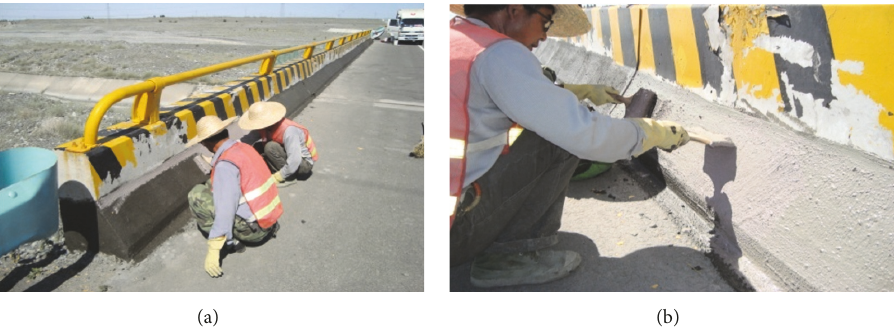
Figure 11: Paining of the acrylic-modified cementitious